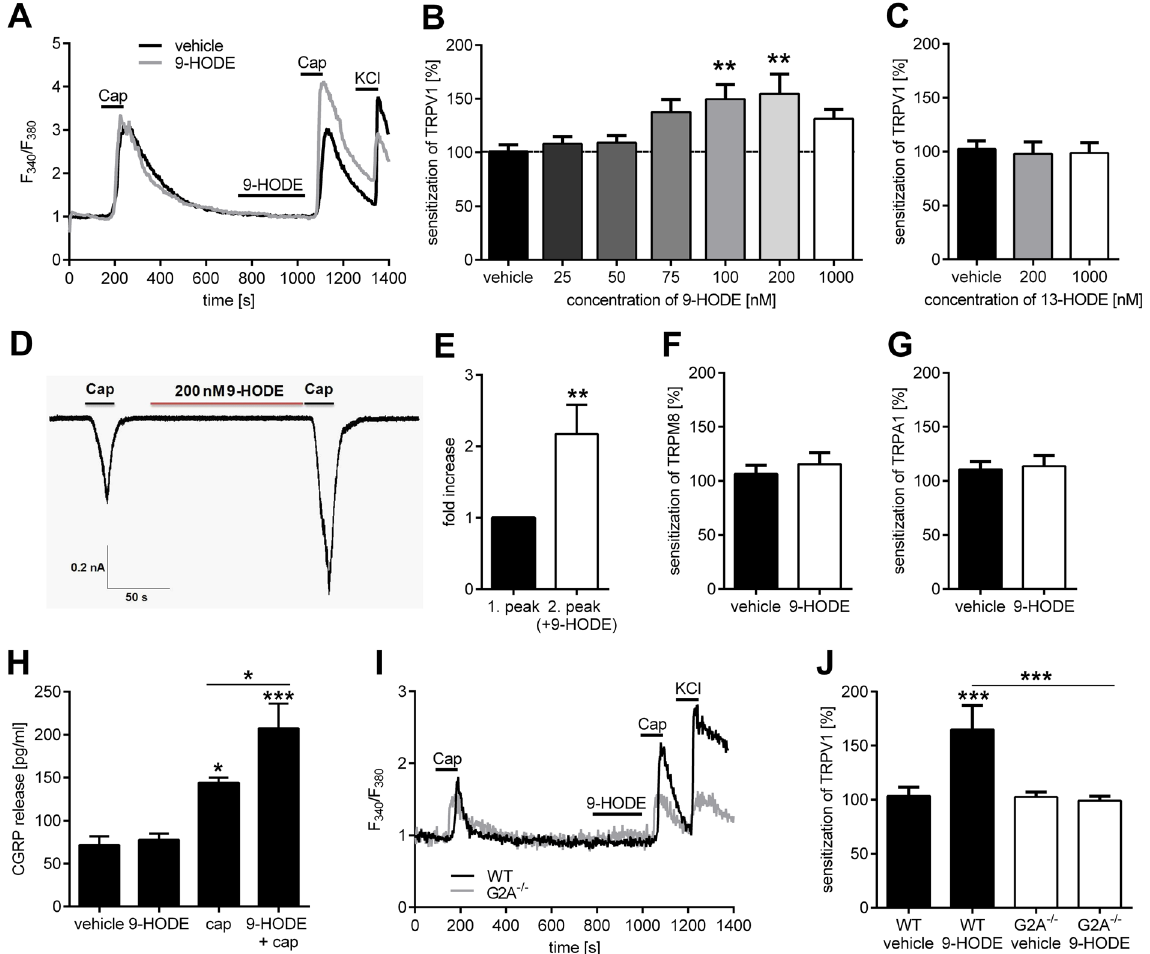
Figure 4. 9-HODE-dependent activation of G2A causes TRPV1 sensitization. ( A ) Stimulation of TRPV1 of adult DRG neurons two times with capsaicin (Cap; 200 nM, 30 s). Incubation with 9-HODE (200 nM, 120 s) before the second stimulus leads to an increased calcium flux compared to the first stimulus ( Δ ratio ). Neurons were identified by responses to KCl (50 mM, 10 s). Shown is a representative trace. ( B ) 9-HODE dose-dependently sensitizes the TRPV1 channel of DRG neurons. Shown is the Δ ratio of the first and second capsaicin stimulus at 9-HODE concentrations ranging from 0 to 1000 nM. Data are presented as mean ± SEM with n = 44–99 neurons per concentration; ** p < 0.01 one-way ANOVA with Bonferroni post-hoc test. ( C ) 13-HODE (200 nM, 120 s) does not increase the Δ ratio of TRPV1-dependent calcium flux in DRG neurons (n = 30–83). ( D ) Sample trace of whole-cell voltage clamp measurement of DRG neurons treated with capsaicin (1 µ M, 15 s) twice. Before the second cap-stimulus, cells were incubated with 9-HODE (200 nM, 3 min). ( E ) Normalized response to first and second capsaicin-stimulus with cells treated like in ( D ) shown as mean ± SEM with n = 11 neurons; ** p < 0.01 unpaired student’s t-test. Effect of 9-HODE on TRPM8 ( F ) of DRG neurons stimulated with menthol (100 µ M, 30 s) and TRPA1 ( G ) stimulated with allyl isothiocyanate (50 µ M, 30 s). The Δ ratio is depicted compared to vehicle (DMSO) with n = 20–33 neurons per condition. ( H ) CGRP release from DRG neurons stimulated with 9-HODE (1 µ M, 10 min), capsaicin (400 nM, 10 min) or both together. Data shown as mean ± SEM from n = 6–8 mice per condition; * p < 0.05 *** p < 0.001 one-way ANOVA with Bonferroni post-hoc test. ( I , J ) Incubation of adult DRG neurons with 9-HODE (200 nM, 120 s) prior to the second capsaicin stimulus (Cap; 200 nM, 30 s) leads to an increased calcium flux compared to the first stimulus ( Δ ratio ) in DRG neurons of wildtype (WT) but not in G2A-deficient mice. Neurons were identified by responses to KCl (40 mM, 10 s). ( I ) Representative trace. ( J ) The quantitative analysis presented as mean ± SEM with n = 46–110 cells per condition; *** p < 0.001 one-way ANOVA with Bonferroni post-hoc